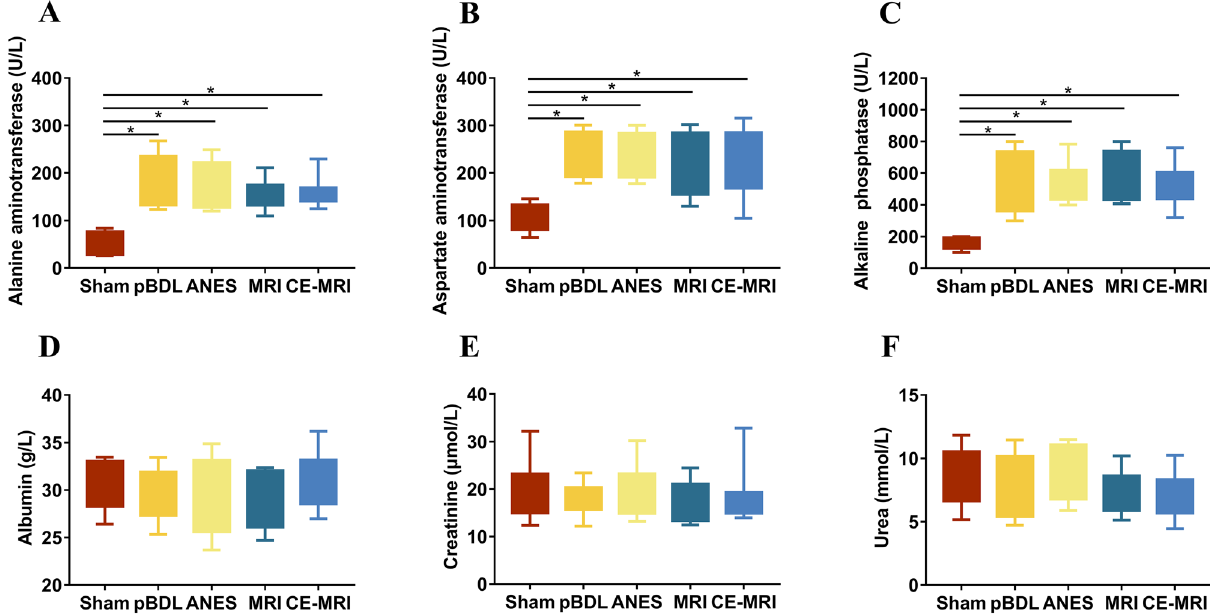
Figure 3. Biochemical data on week 6 in all groups. ( A – C ) Alanine aminotransferase, aspartate aminotransferase, and alkaline phosphatase levels were increased in the pBDL groups, compared with the sham group. These parameters in the repeated MRI and CE-MRI groups remained unchanged compared with the pBDL group. ( D – F ) Albumin, creatinine, and urea levels did not show significant increases after pBDL and repeated MRI examinations. Sham, only suture the abdominal wall. pBDL, partial bile duct ligation surgery alone; ANES, repeated anesthesia in the pBDL model; MRI, repeated magnetic resonance imaging under anesthesia in the pBDL model; CE-MRI, repeated contrast-enhanced magnetic resonance imaging under anesthesia in the pBDL